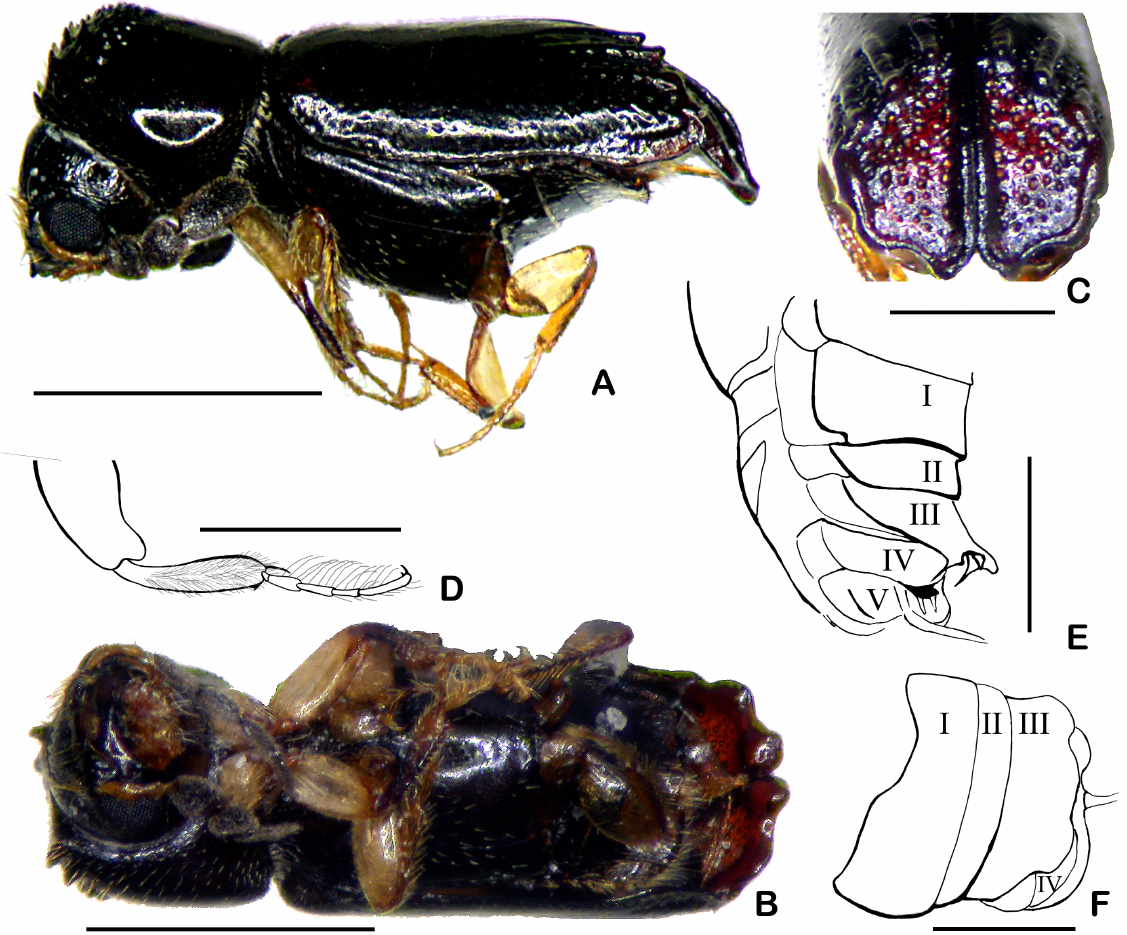
Fig. 2. Octomeristes pusillus Liu & Beaver, gen. et sp. nov., paratype, ♀ (LYL). A . Lateral view. B . ventral view. C . Posterior view of elytral declivity. D . Proleg showing long, curling hairs on ventral side of tarsi and dense, fine hairs on inner face of tibia. E . Latero-ventral view of abdomen showing modified 3 rd to 5 th ventrites. F . Ventral view of abdomen. Scale bars: A–B = 1 mm; C–F = 0.5 mm (in e–F: i to v are the 1 st to 5 th ventrites, O is